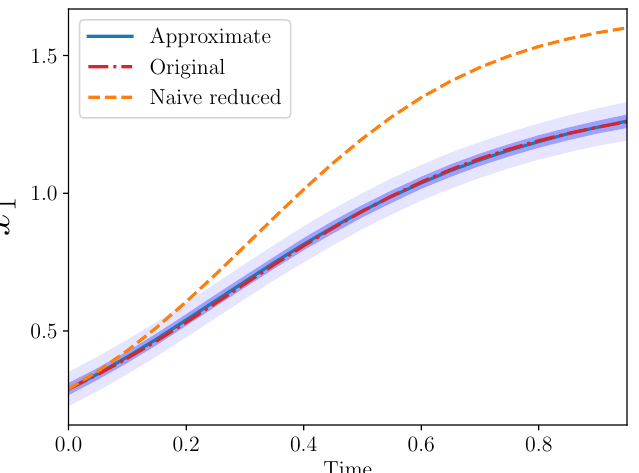
Figure 2. Approximate algebraic model for β = 2, α = 1. The darker blue band represents the 50% confidence interval (CI) and the lighter blue the 95%